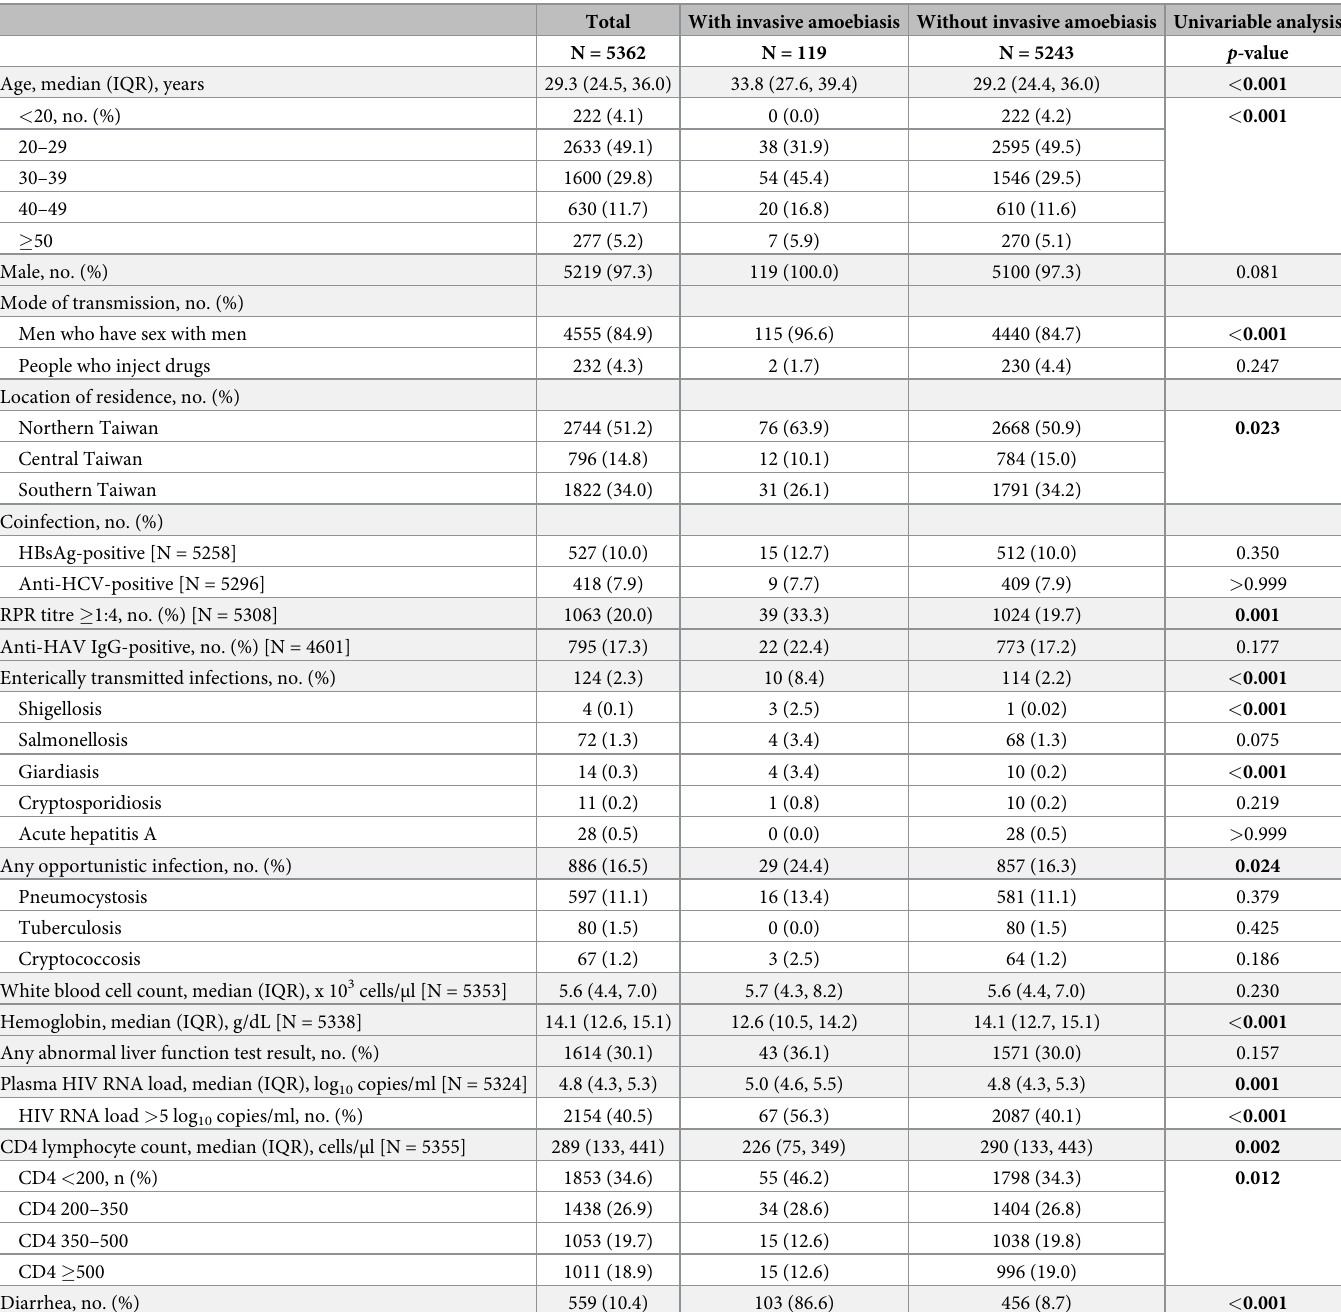
Table 1. Comparisons of characteristics between newly diagnosed people living with HIV who had and those who did not have invasive